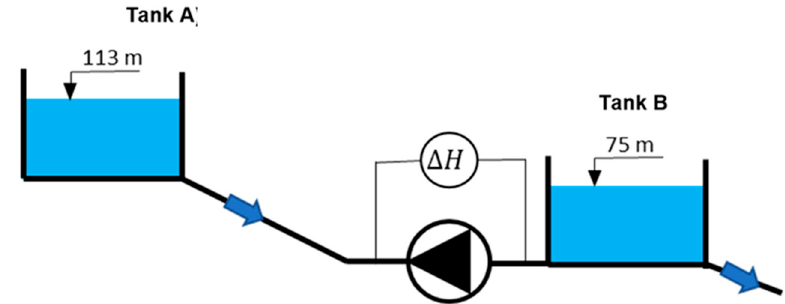
Figure 3. The layout of the case study scenario. ∆ H represents the net hydraulic jump available.